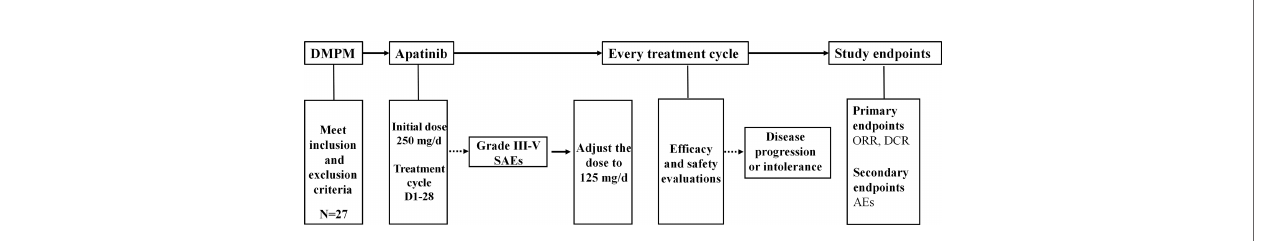
FIGURE 1 | The fl ow chart of apatinib treatment for DMPM. DMPM, diffuse malignant peritoneal mesothelioma; SAEs, serious adverse events; ORR, objective response rate; DCR, disease control rate; AEs,